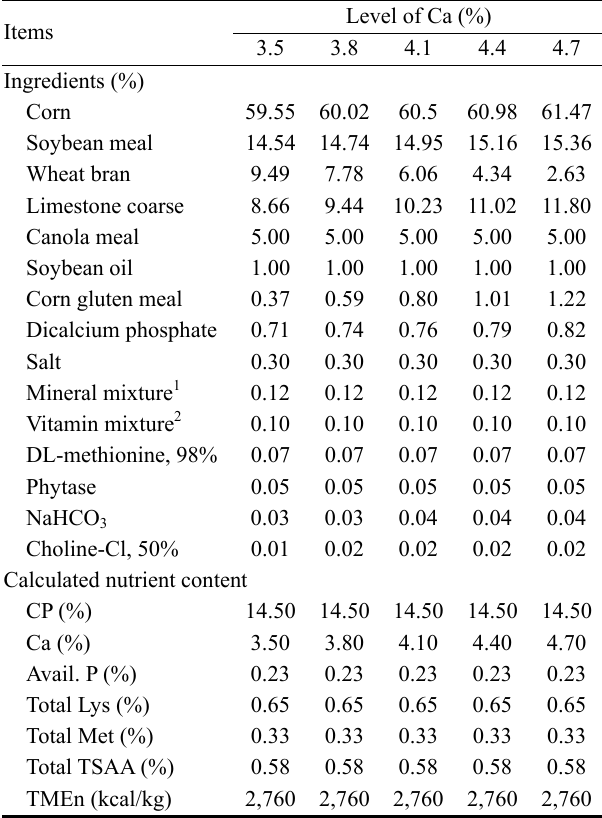
Table 1. Ingredient composition of experimental diets,